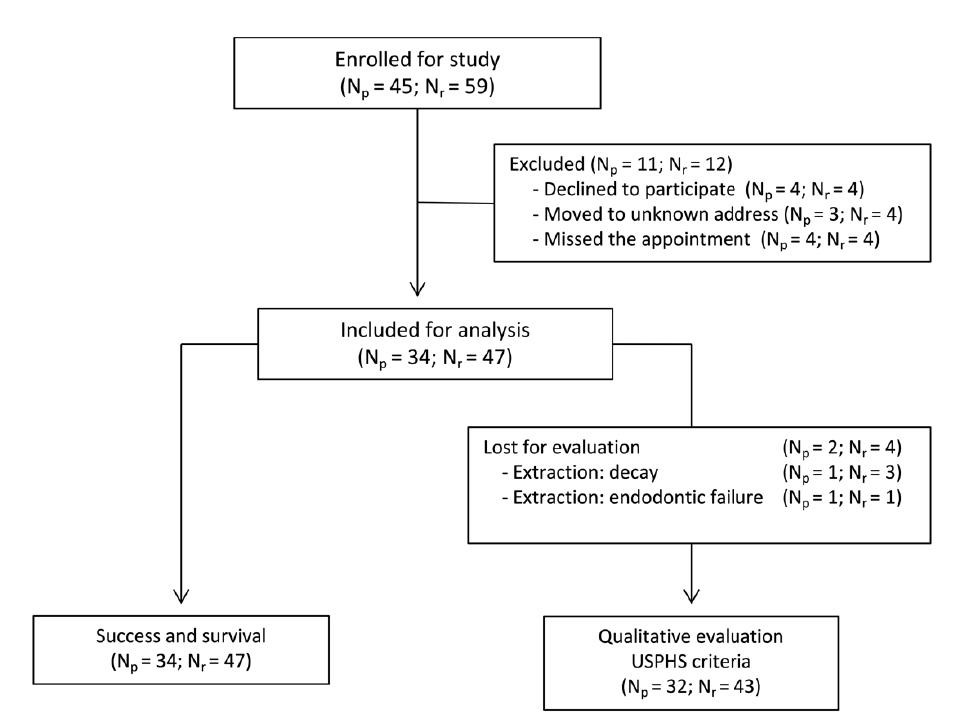
Figure 1. Flow chart (N p = number of patients; N r = number of restorations). Table 4. Distribution of the involved restoration types.